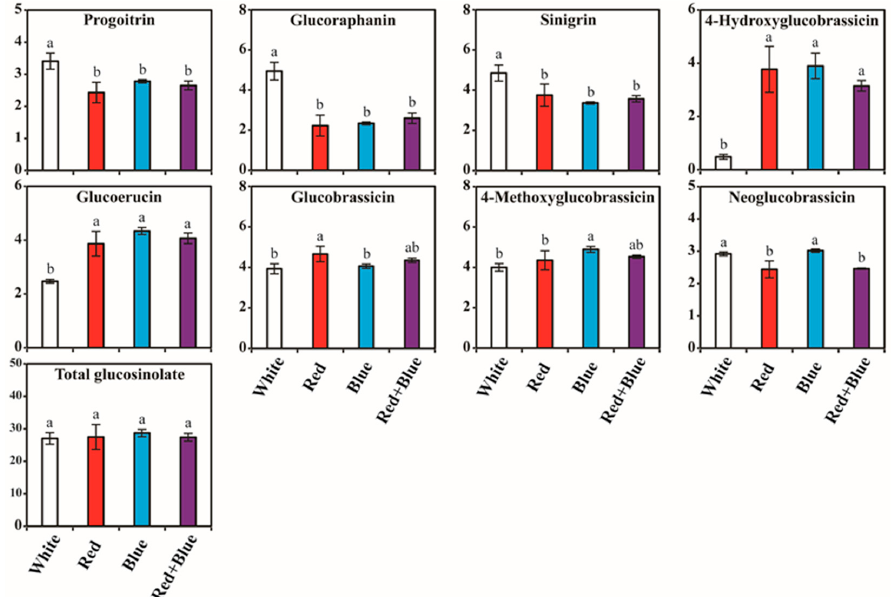
Figure 4. Glucosinolate contents ( µ g/g DW) in kohlrabi sprouts irradiated with different LED lights. Samples were collected after 10 days of growth. Mean values marked with different alphabetical le tt ers were signi fi cantly di ff erent ( p < 0.05, ANOVA, DMRT).